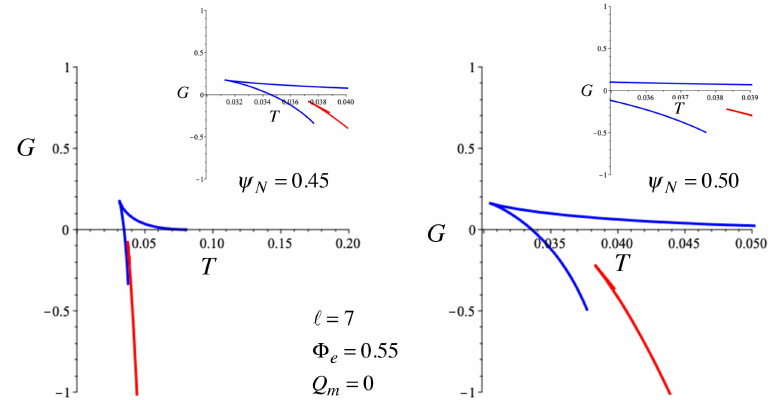
Figure 22 . Alternate Fractured Cusp Development at fixed electric potential. This sequence of plots of free-energy vs. temperature shows the development of the fractured cusp for larger values of ψ ( I ) for vanishing magnetic charge. The blue curve is the negatively charged branch; the insets N highlight the relationship between the negative and positive branches. Here ‘ = 7 and Φ e = 0 . 55